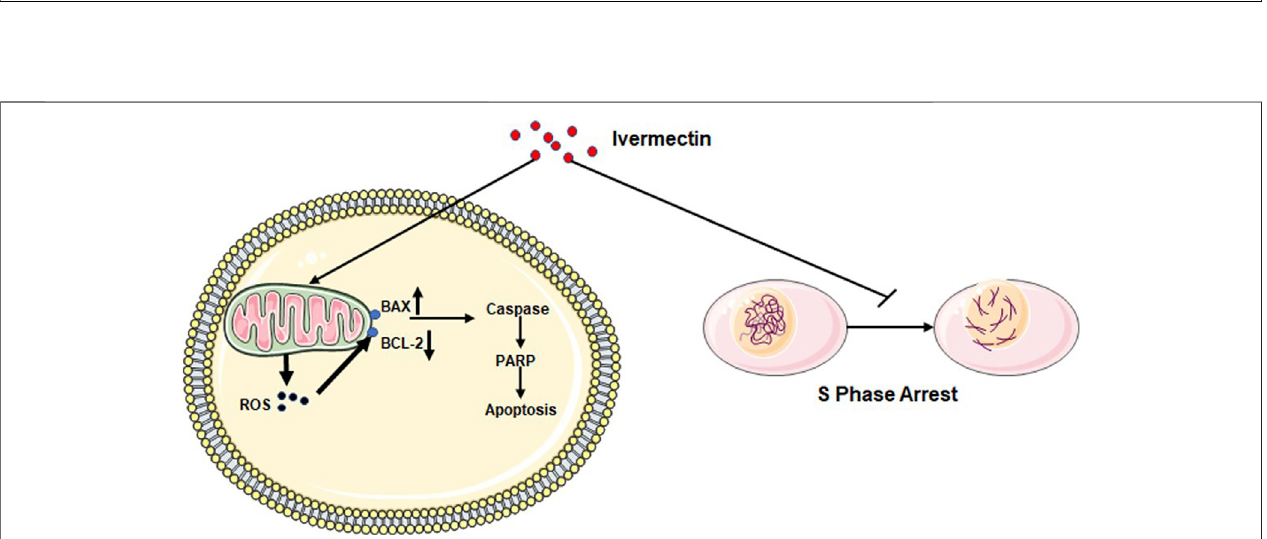
FIGURE 11 | Diagram of the mechanism of ivermectin inhibiting the proliferation of colorectal cancer cells.